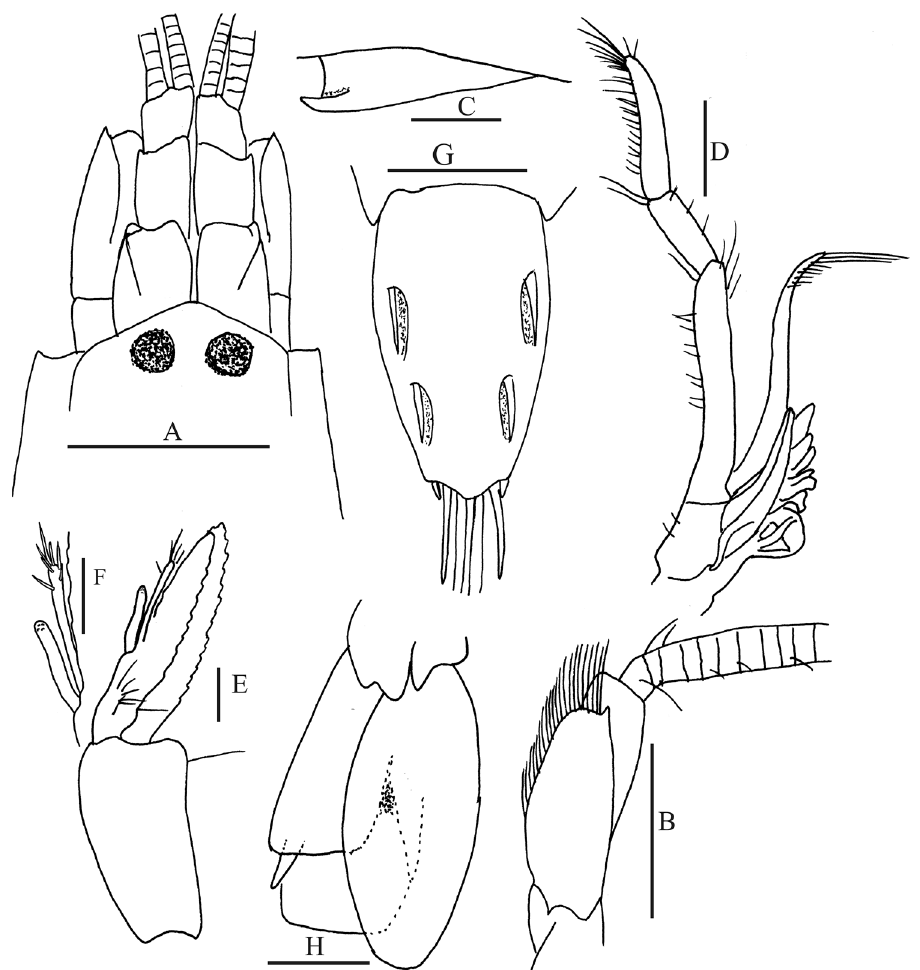
Figure 6. Leptalpheus melendezensis sp. n. Holotype male, CL 4.1 mm (EMU10582); A anterior portion of carapace and cephalic appendages, dorsal view B right antenna, lateral view C tooth on ventrome- sial carina of first segment of antennular peduncle, mesial view D third maxilliped E second pleopod F detail of masculina and internal appendix G telson, dorsal view H left uropod, dorsal view. Scale bars A, B 1 mm; C, E 0.2 mm; D, G, H 0.5